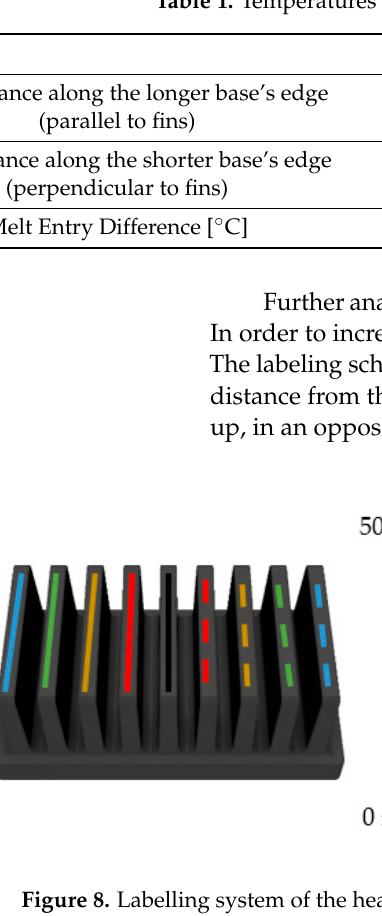
Figure 9. Averaged temperature at the top of fins (fins’ surface furthest from the base) of both measured heat sinks in the “upside-down” position. Each set of temperatures is fitted with a 2nd order polynomial curve.